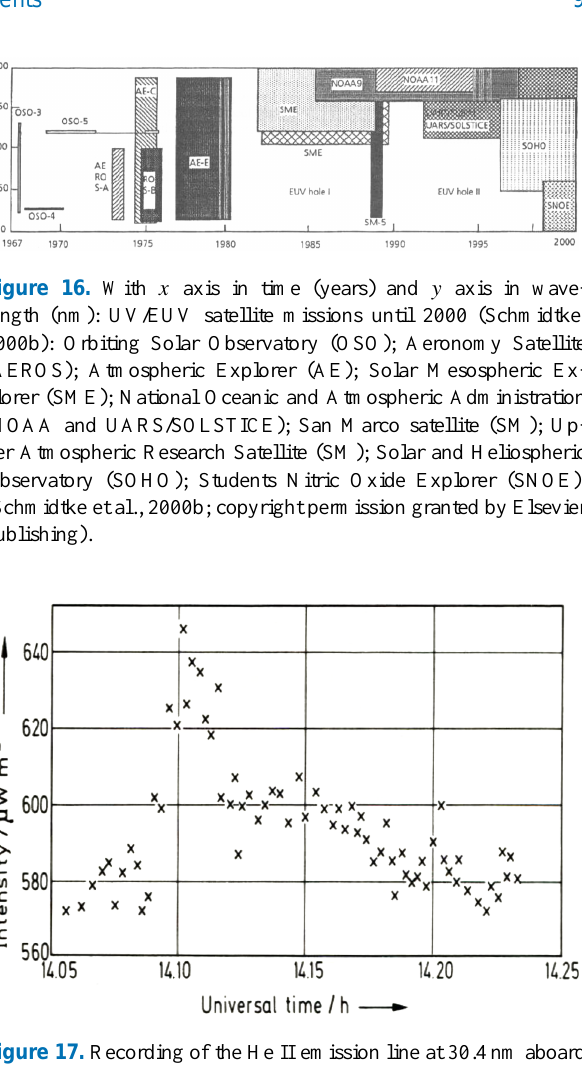
the satellite AEROS-A during a 2B solar flare on 15 June 1973